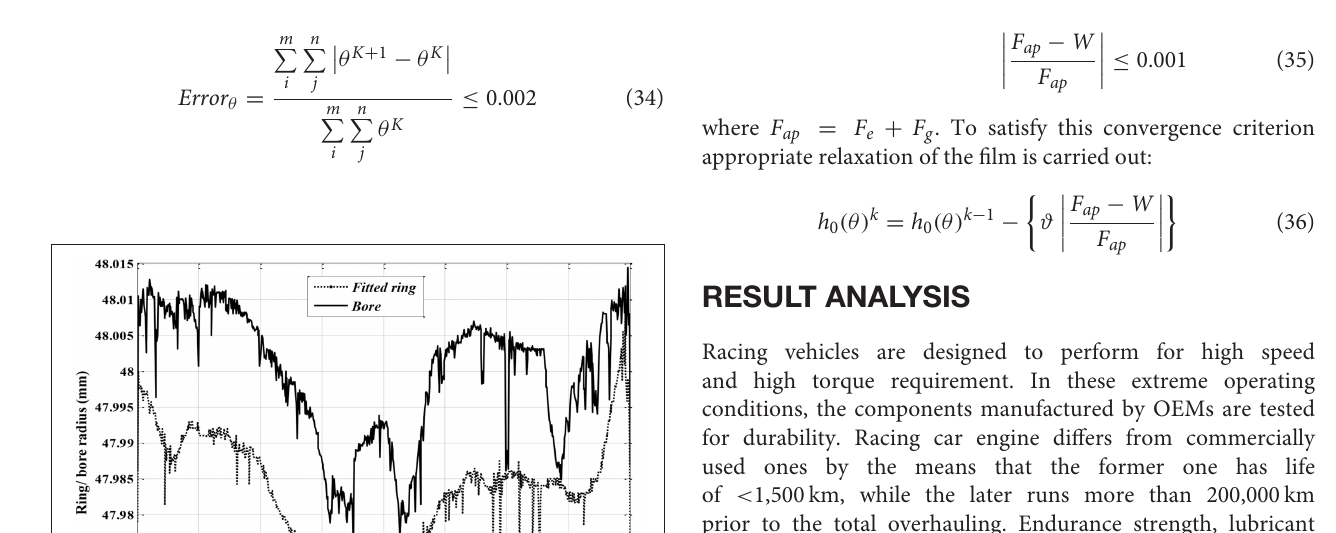
20 m/s). (C) Power ( θ c =